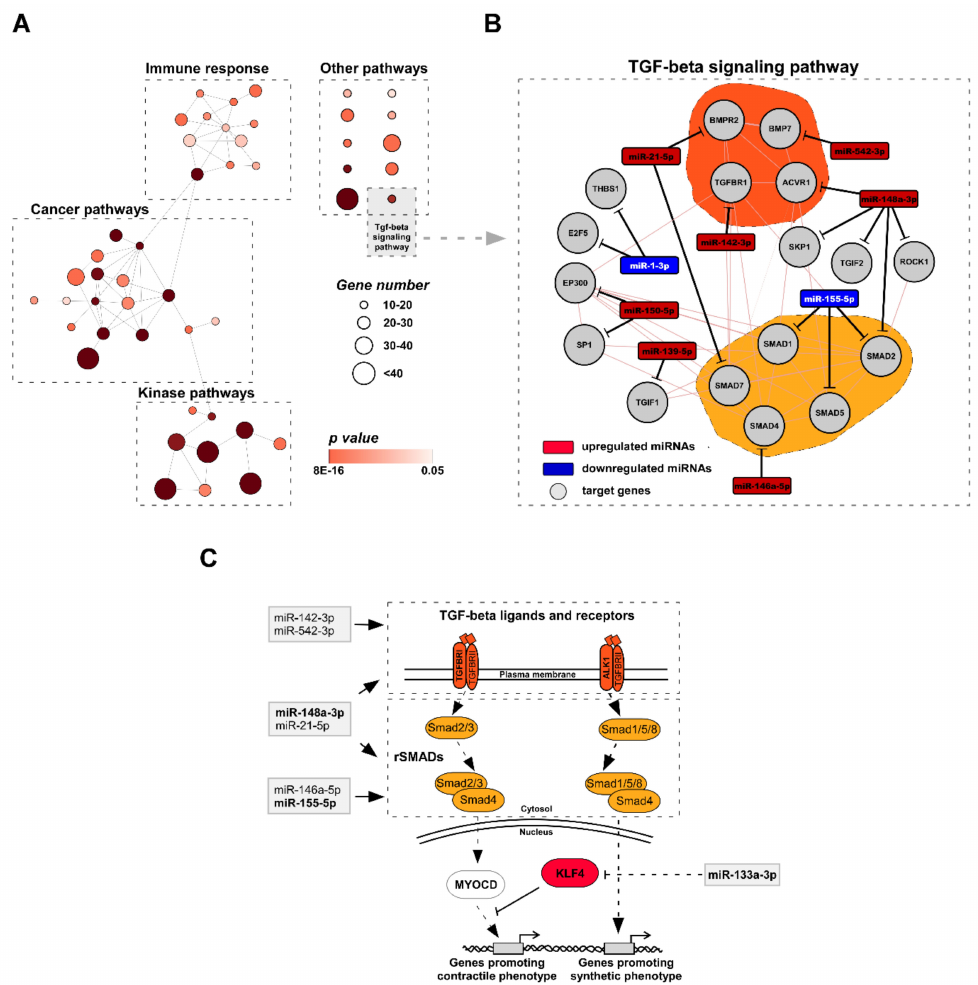
Figure 3. Functional analysis of target genes of miRNAs dysregulated in TAA. ( A ) Network analysis of 48 KEGG categories specified three clusters of closely related categories including immune response, cancer, kinase signaling pathways and ten separate groups that were not significantly associated with any other category. TGF- β signaling pathway is included in a grey box. The size of node represents gene number in particular, KEGG category, the node color – the significance level value of particular KEGG category. Edges indicate a statistically significant association between categories. ( B ) Expanded molecular network of miRNAs and their potential target genes involved in TGF- β signaling pathway. Grey nodes denote target genes, red and blue – upregulated and downregulated miRNAs, respectively. Dark orange area covers TGF- β ligands and receptors; light orange – regulatory SMAD s (r SMAD s). ( C ) Simplified hypothetical schema of TGF- β signal transduction in TAA tissue cells. miRNAs, which were di ff erentially expressed in TAA tissue (grey boxes), could potentially disturb TGF- β signaling by targeting TGF- β ligands, receptors or r SMAD s leading to dysregulation of MyoCD – KLF4 transcription regulator axis and further TAA